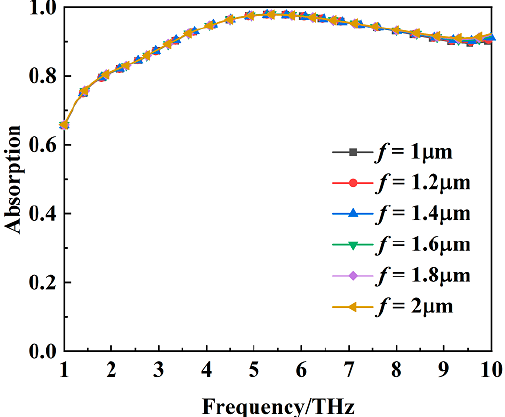
Figure 11. The absorption of the metamaterial absorber when the conductivity of VO 2 film is 2 × 10 5 S/m at different values of the structural dimension parameter f.